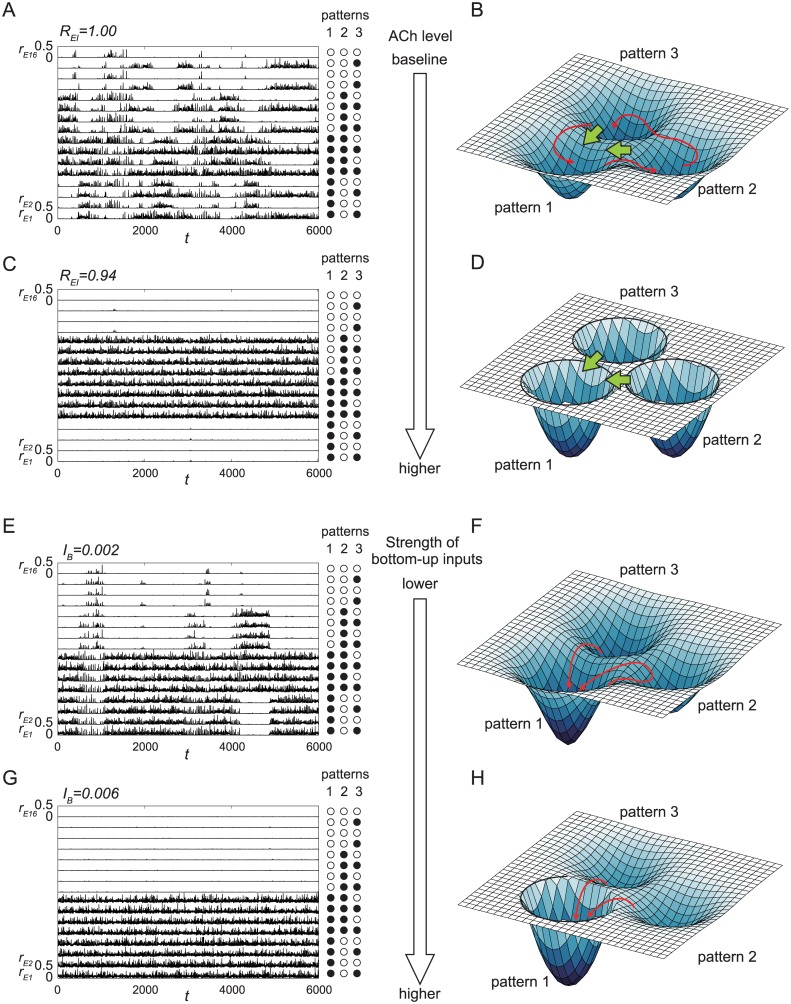
Relationship between network dynamics and deformation of the attractor landscape.(A-D) ACh-controlled deformation of the attractor landscape. When ACh is released, the inhibition rate REI decreases because of disinhibition of inhibitory synapses projecting onto excitatory neurons. (A, C) Dynamics of the network with 16 modules with NE = 1000 and NI = 250 for (A) REI = 1.00 and (C) REI = 0.94. (B, D) The corresponding attractor landscapes. The red arrows show the typical transitive dynamics. The green arrows show the influence caused by the glutamatergic spike volleys with strength IT. (E-H) Deformation of the attractor landscape caused by the bottom-up external inputs with strength IB. (E, G) Dynamics of the network with 16 modules with NE = 1000 and NI = 250 for (E) IB = 0.002 and (G) IB = 0.006. (F, H) Corresponding attractor landscapes. The red arrows show the typical transitive dynamics.